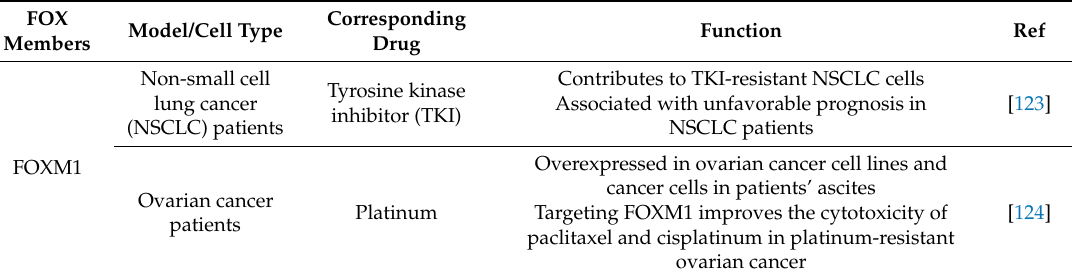
Table 1. Contributions of forkhead box (FOX) proteins to drug resistance of cancer